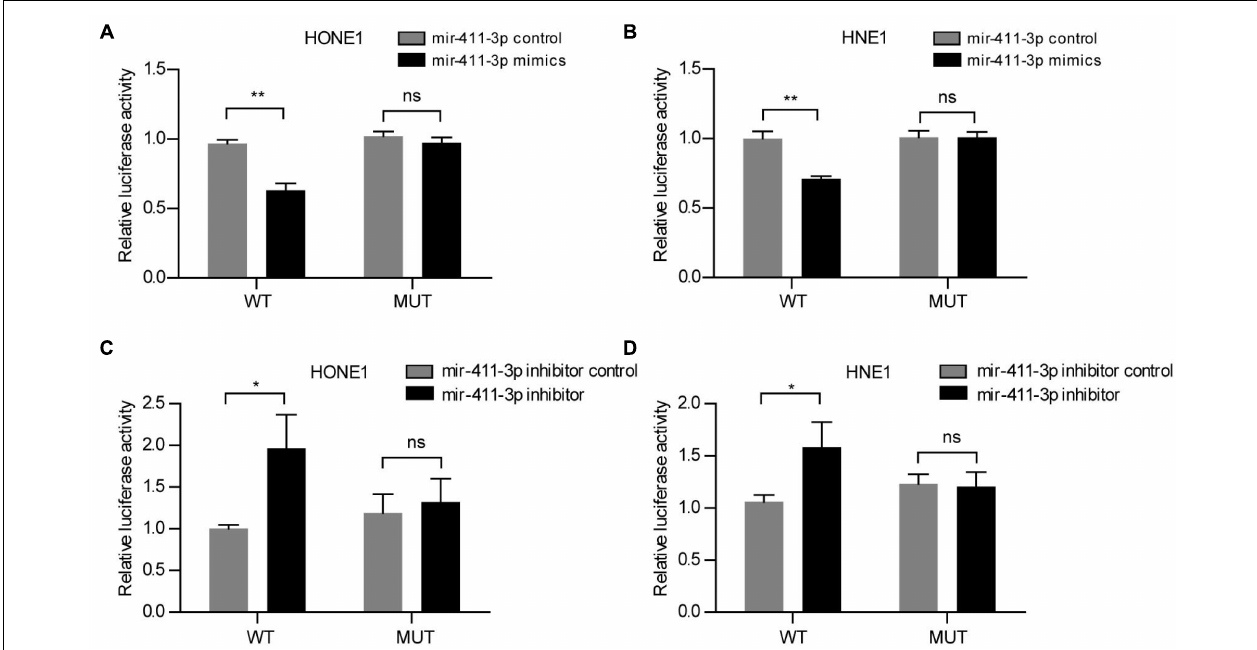
FIGURE 3 | rs12497104 destroys the binding between mir-411-3p and linc00312. (A) Relative luciferase activity of the wild type linc00312 (WT) and rs12497104 mutant type linc00312 (MUT) reporter vector that co-transfected with mir-411-3p mimics or mir-411-3p control in HONE1 cells. (B) Relative luciferase activity of the WT and MUT reporter vector that co-transfected with mir-411-3p mimics or mir-411-3p control in HNE1 cells. (C) Relative luciferase activity of the WT and MUT reporter vector that co-transfected with mir-411-3p inhibitor or mir-411-3p inhibitor control in HONE1 cells. (D) Relative luciferase activity of the WT and MUT reporter vector that co-transfected with mir-411-3p inhibitor or mir-411-3p inhibitor control in HNE1 cells. * P < 0.05; ** P < 0.01.